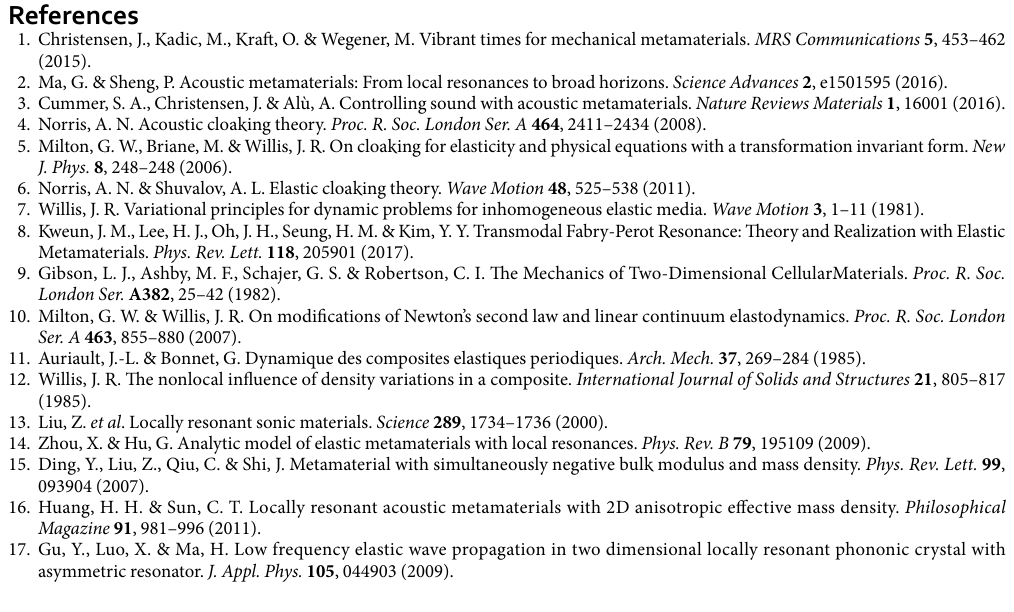
6 SCiEntiFiC REPORTs | 7: 13197 | DOI:10.1038/s41598-017-13322-2